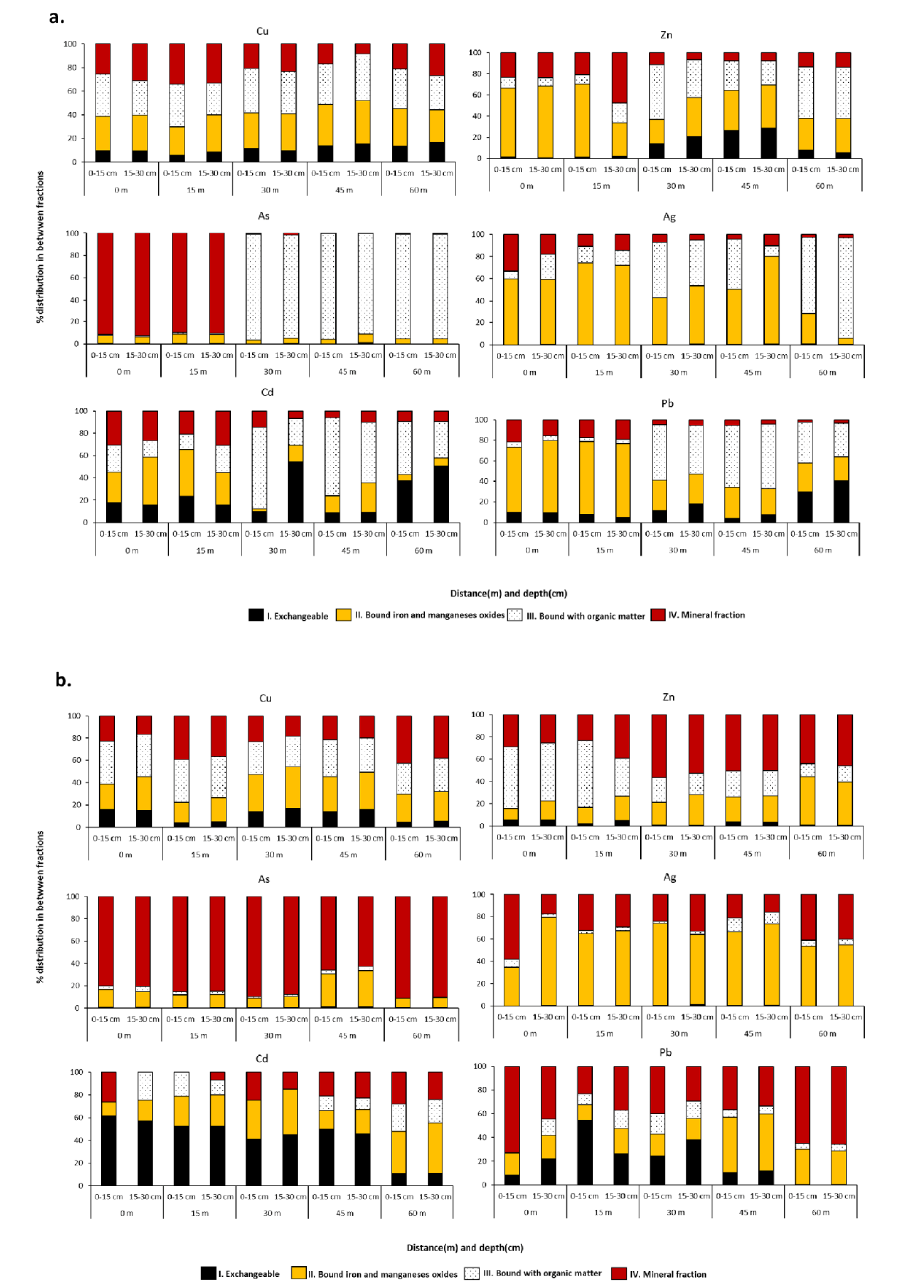
Figure 4. Percentage distribution of elements in four fractions by sequential extraction for five distances (0–60 m) and two depths (0–15 et 15–30 cm) from sampling area #1 ( a ) and #2 ( b ) in Hualgayoc district. In general, no significant differences were found in the fractionation of Pb, Zn, Cu, As, Ag, and Cd between the upper (0–15 cm) and lower (15–30 cm) layers of soil. Out of 60 paired samples, only 6 (site #1: Zn—15 m, Ag—45 m and Cd—30 m and in site #2: Ag—